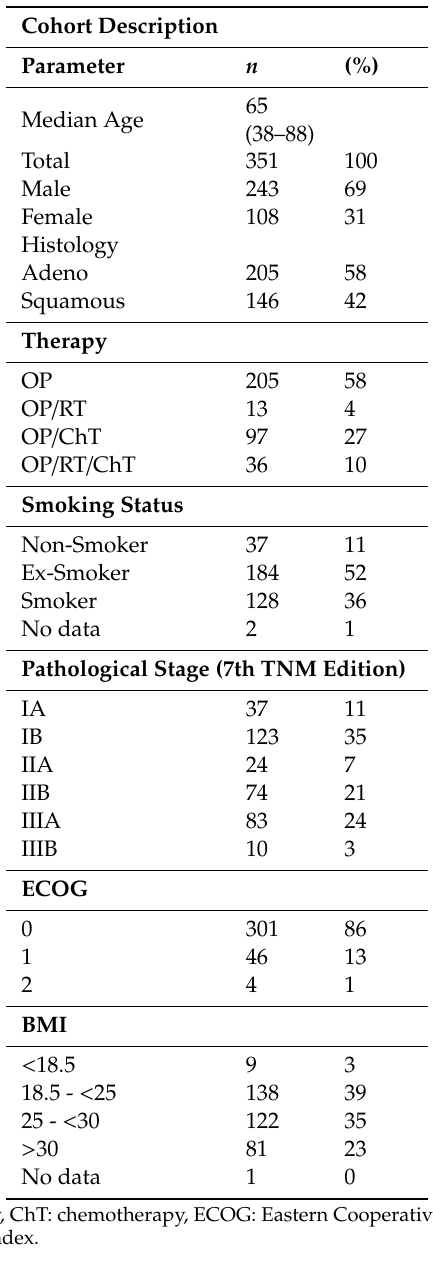
Table 1. Patient Cohort